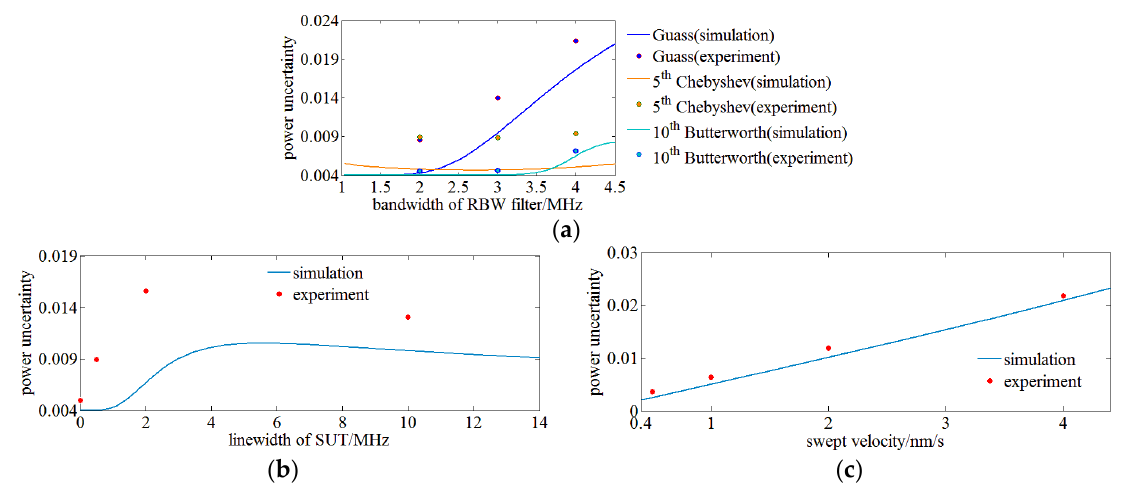
Figure 8. ( a ) Verification of RBW filter’s type on power uncertainty of OENF system for OSA; ( b ) Verification of SUT’s linewidth on power uncertainty of OENF system for OSA; ( c ) Verification of swept velocity of LO on power uncertainty of OENF system for OSA.